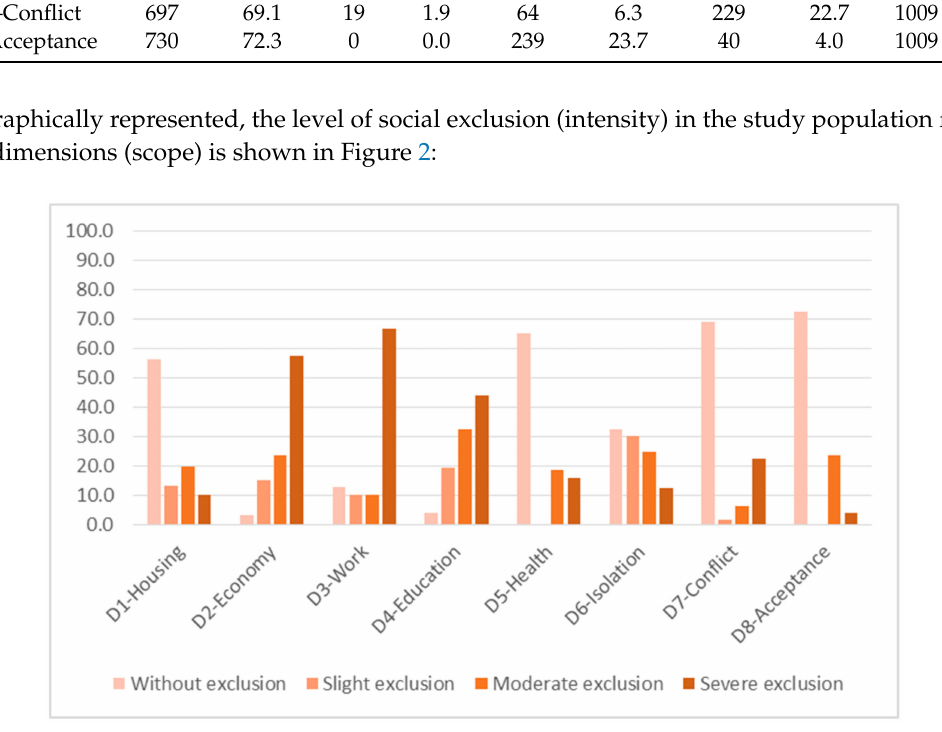
Figure 2. Intensity and scope of social exclusion